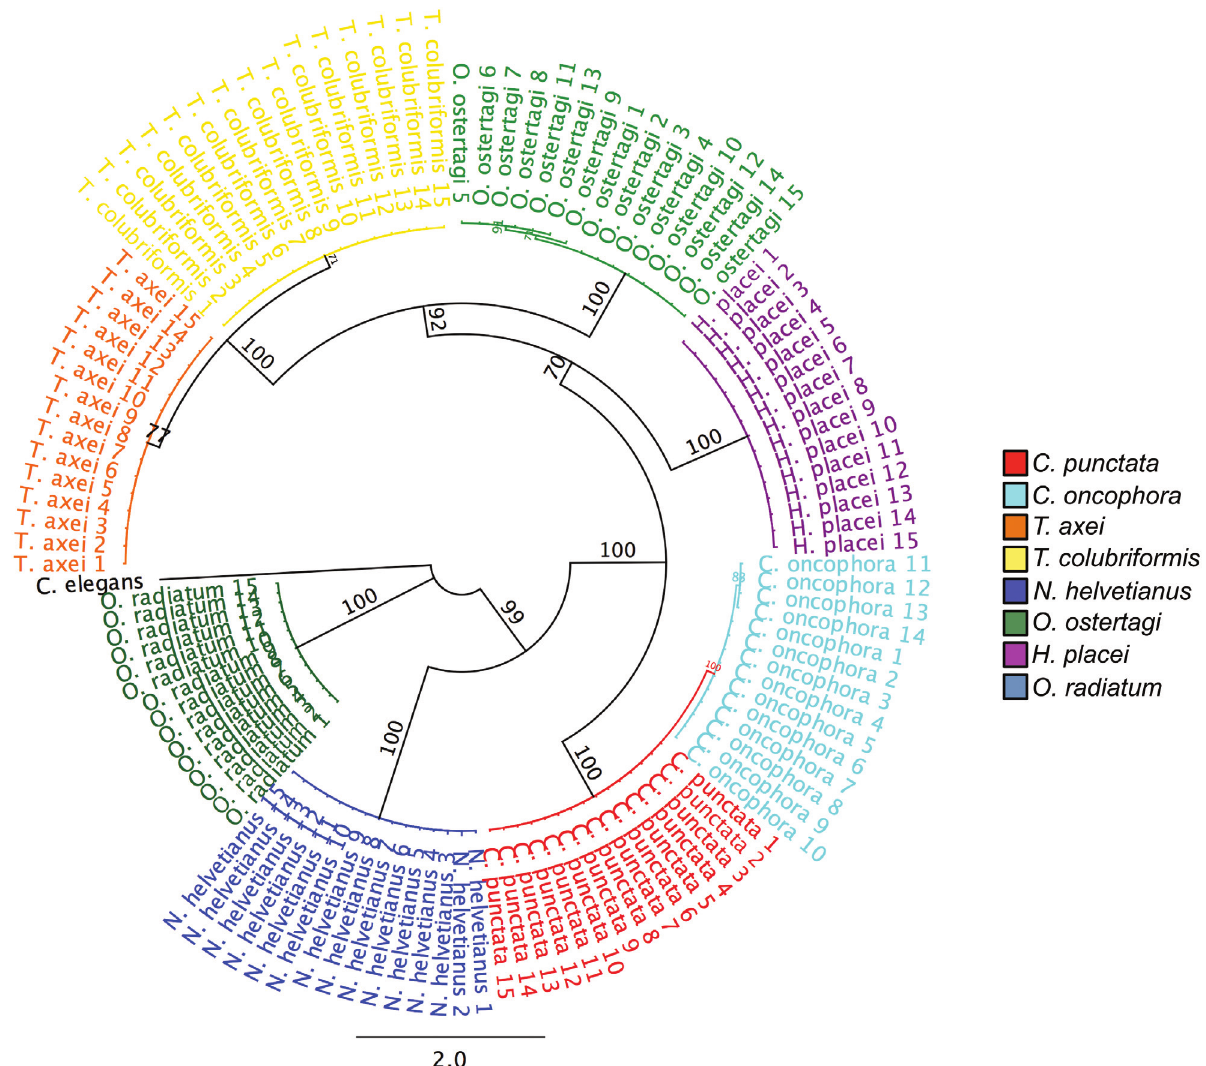
Fig 1. Neighbor-joining tree of ITS-2 rDNA sequences obtained from 8 different parasitic nematode species from cattle. ITS-2 rDNA amplicons were directly sequenced by Sanger sequencing from 15 individual L3 larvae obtained from experimentally passaged strains for each of eight cattle parasite species. The neighbor-joining tree (Jukes-Cantor model) was computed with 2000 bootstrap replicates and rooted on C . elegans ITS-2 (Accession: JN636100) using Geneious version 7.1.5 created by Biomatters. Available from http://geneious.com/. Bootstrap values > 70 are shown, values > 80 are considered to be